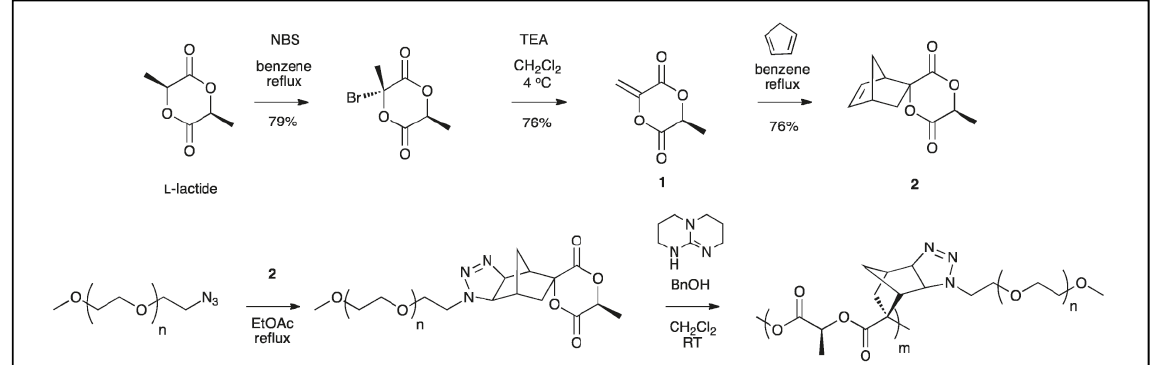
Figure 4. Reaction scheme for the preparation of PLA- g -PEG (from Castillo et al. [18], copyright American Chemical Society, reproduced with permission).